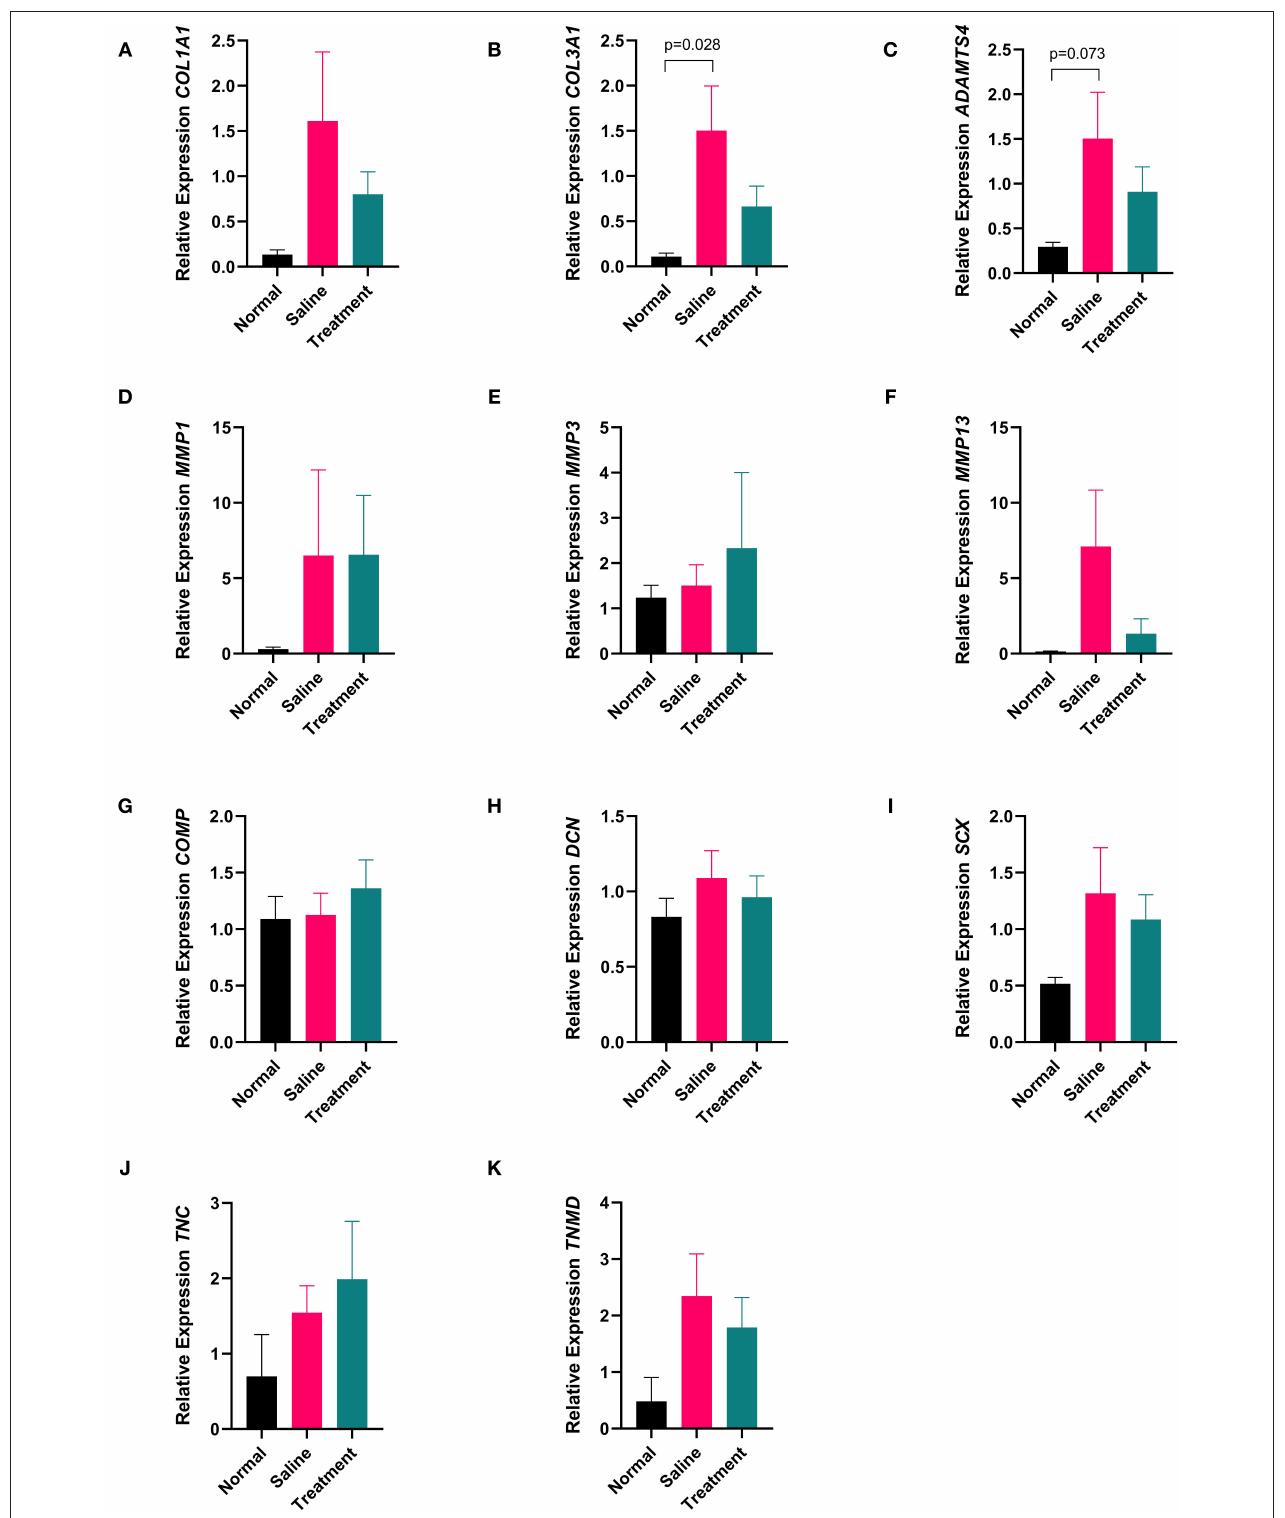
FIGURE 6 | Quantitative PCR data showing expression (A) COL1A1 , (B) COL3A1 , (C) ADAMTS4 , (D) MMP1 , (E) MMP3 , (F) MMP13 , (G) COMP , (H) DCN , (I) SCX , (J) TNC , and (K) TNMD from tendon collected 16cm DACB 12-weeks following intra-lesional injection with saline or APS. Mean ± SEM for 8 horses are shown. Data were analyzed using the 1 Ct method where fold change is expressed as 2 − 11 Ct using 18S as a reference gene and normal tendon as the calibrator ( n = 8).